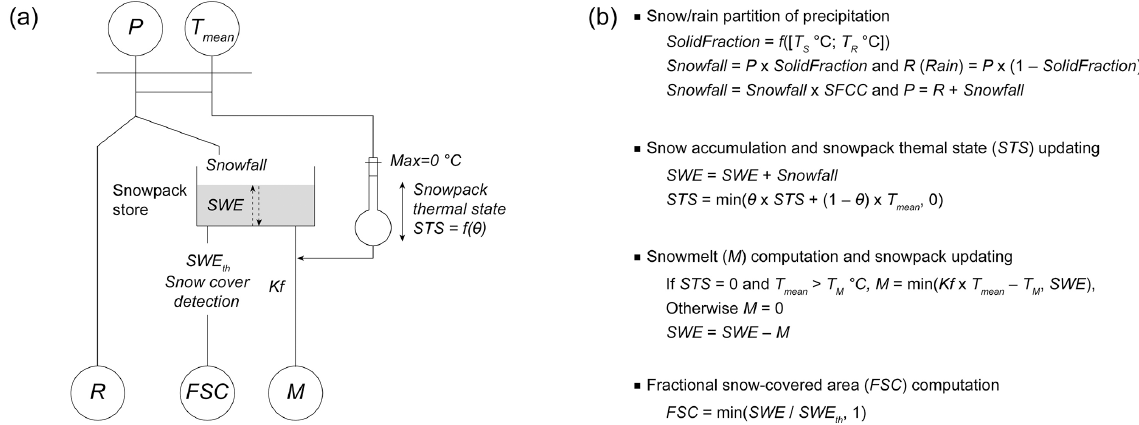
Figure 3. Snow accounting routine: (a) conceptual scheme and (b) associated equations (modified from Valéry et al., 2014). P , R , T mean , M , and FSC stand for total precipitation, rainfall, mean temperature, melt, and factional snow cover, respectively.